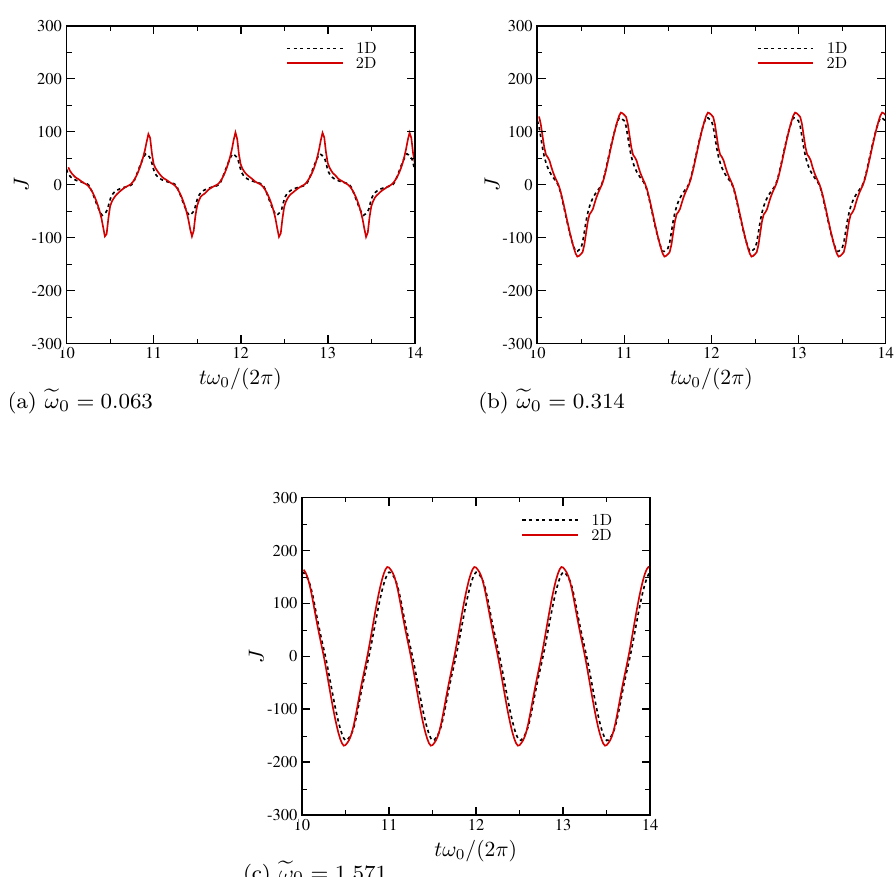
Figure 14. Surface current per unit area for ( a ) periods are